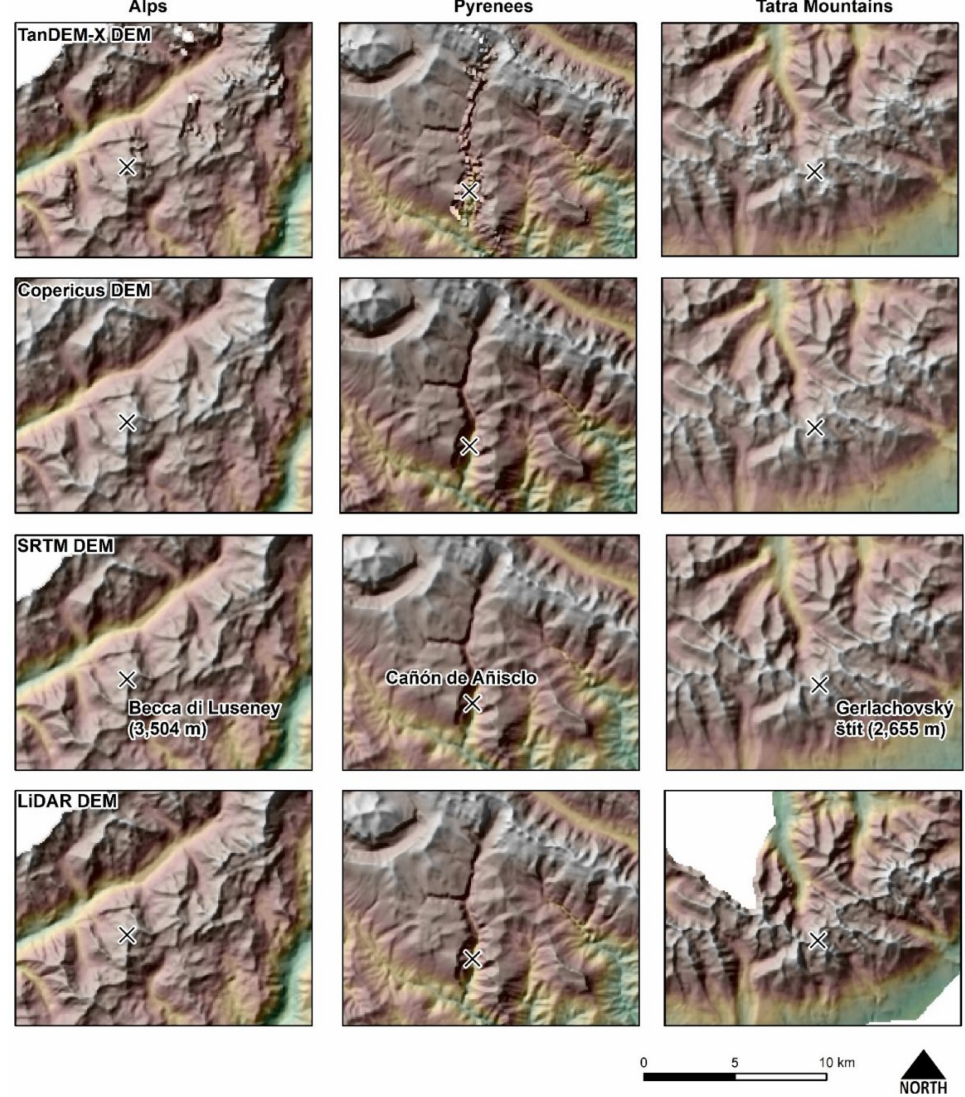
Figure 4. Hill-shaded terrain of problematic locations in the three study areas, the Alps ( left ), the Pyrenees ( middle ), and the Tatra Mountains ( right ), represented by TDX90, COP90, SRTM90, and the LiDAR DSM. Note that while COP90 and SRTM90 correspond to the LiDAR DSM, the terrain represen- tation in TDX90 shows artefacts. The three examples show the areas of the Becca di Luseney